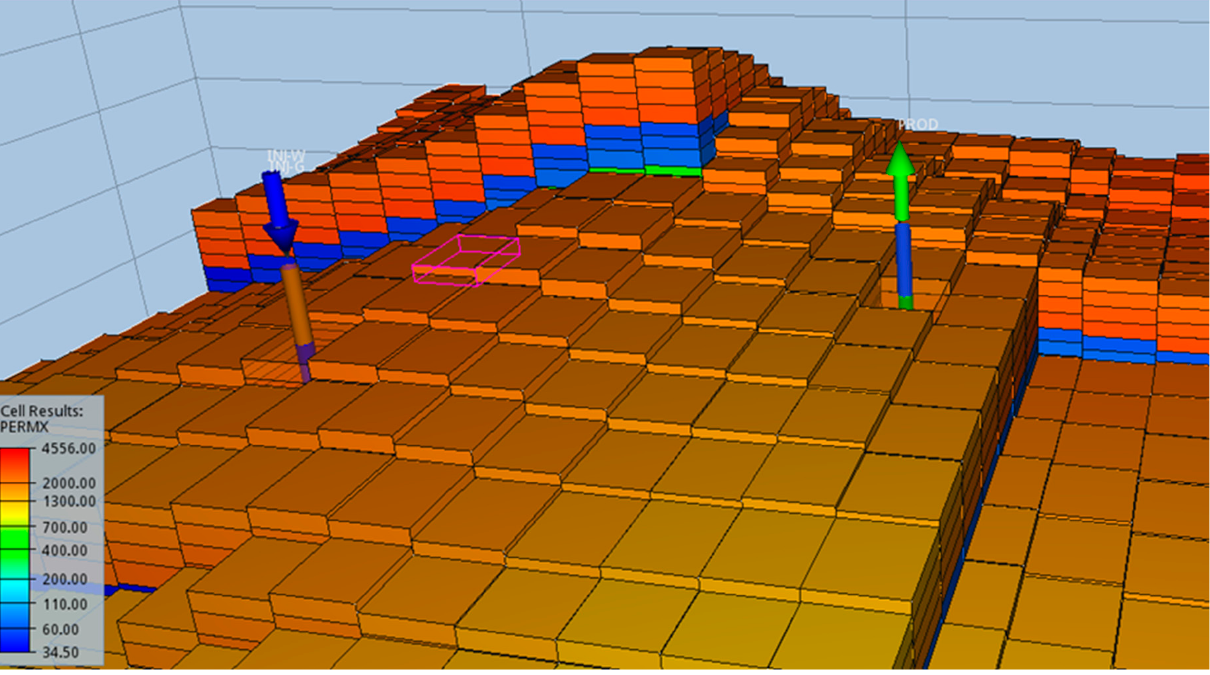
Figure 15. Illustration of the 3D model, where permeability and well placements are indicated. Table 8. Input and calculated parameters for the 3D model. ‘Low/hi’ indicates degree of hysteresis in parameters x 3 , x 4 , while for parameters x 5 to x 8 , values are calculated from two oil